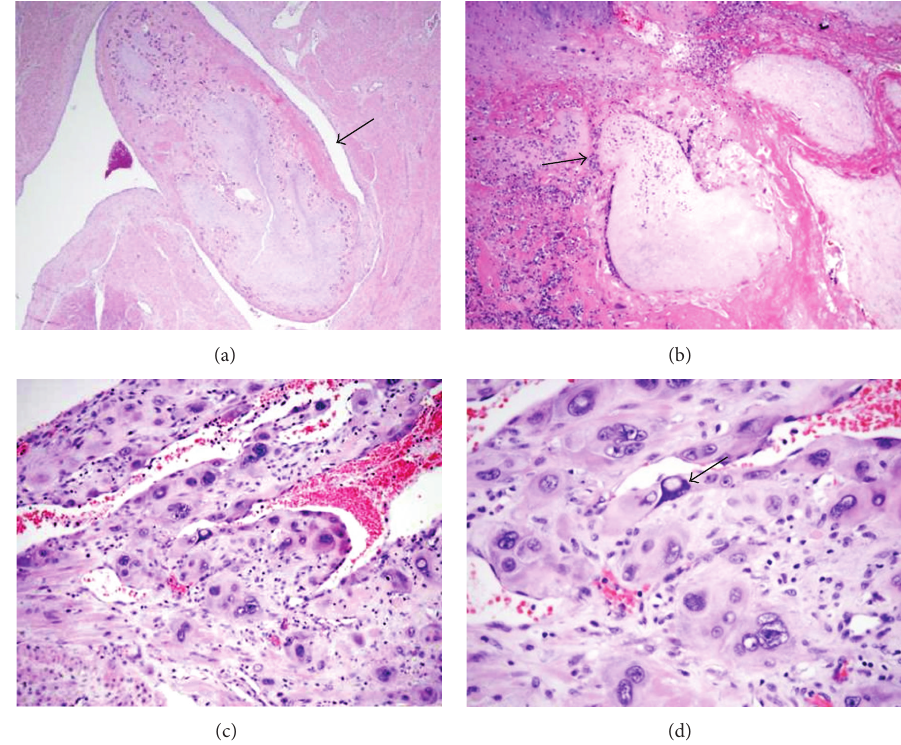
Figure 3: Hydropic villi invading into the myometrium and blood vessels (arrow) ((a) and (b) H&E, x40); markedly atypical trophoblastic proliferation with chemotherapy effect and exaggerated placental site (arrow) ((d) H&E, ×